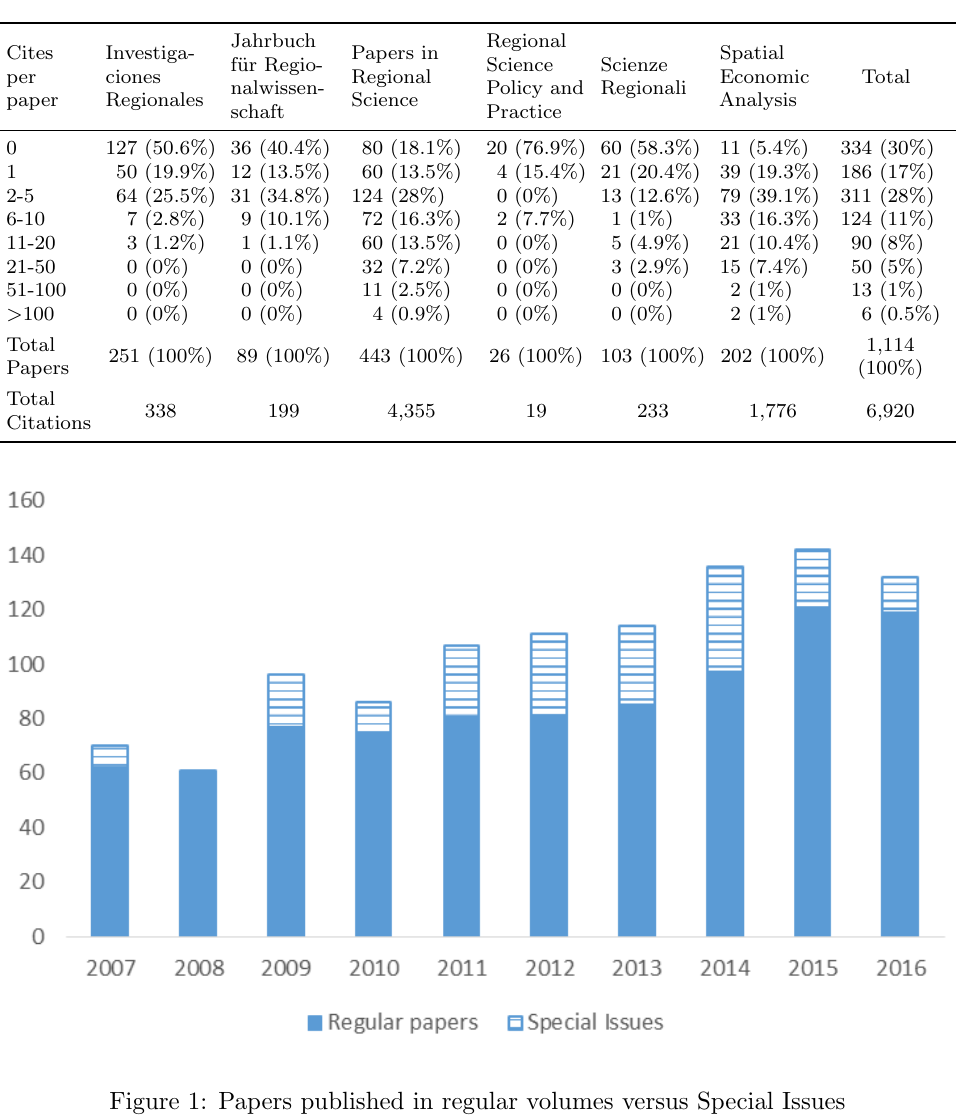
Figure 1: Papers published in regular volumes versus Special